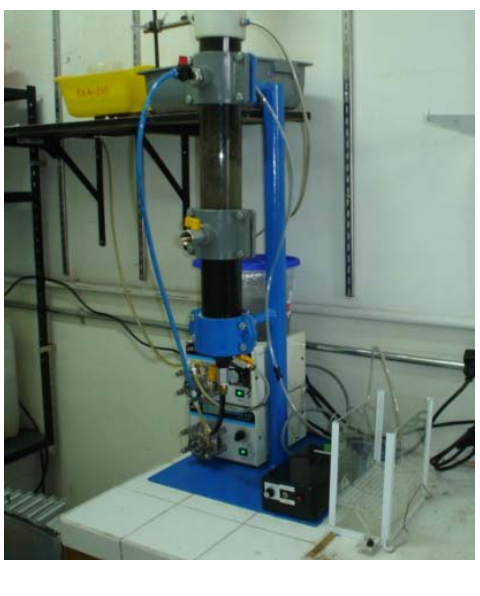
Figure 2. UASB reactor.